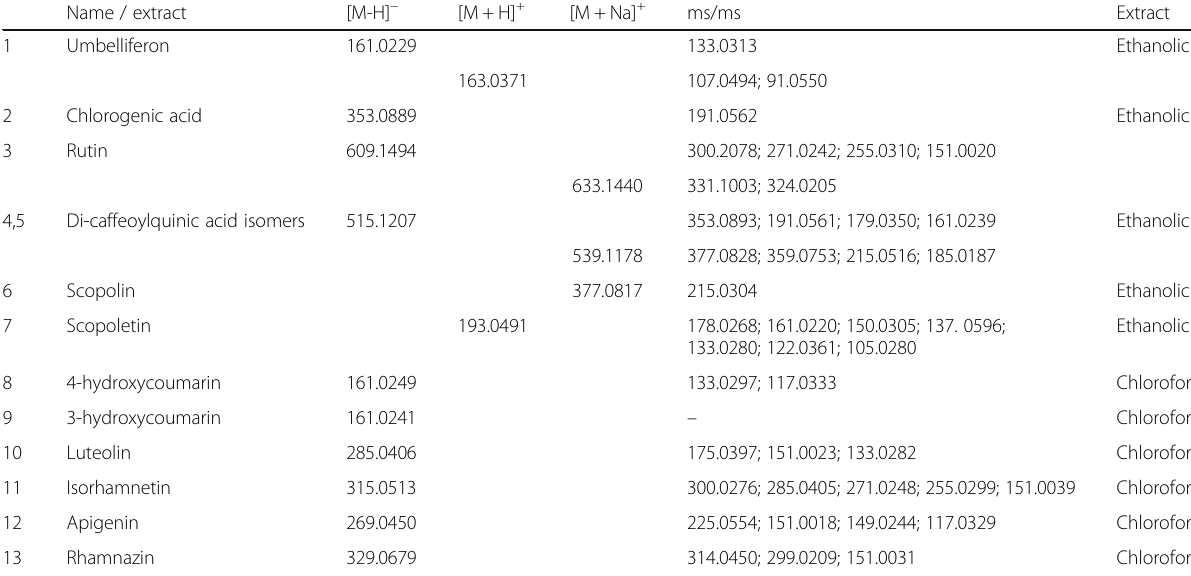
Table 2 Compounds identified by LC-MS in ethanolic and chloroform extracts from A. gmeilinii Name /